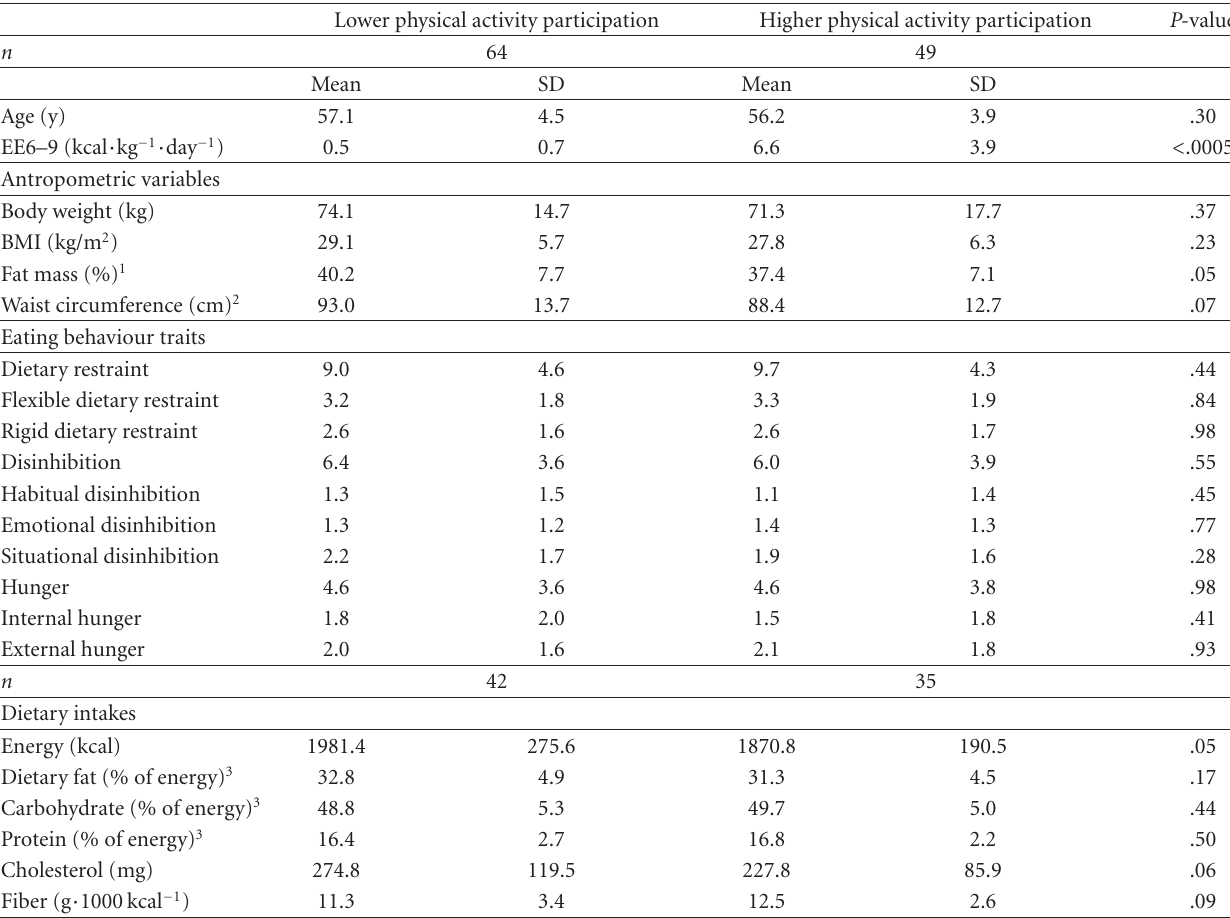
Table 1: Anthropometric variables, eating behaviour traits, and dietary intakes in women characterized by either lower or higher physical activity